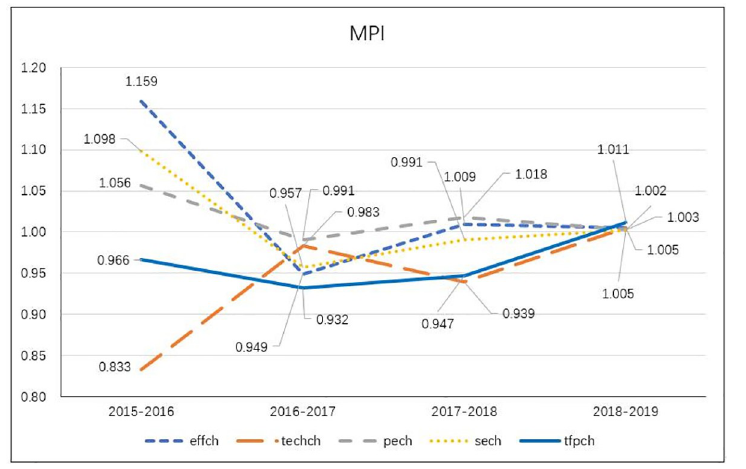
Fig 1. Summary of the Malmquist index of annual